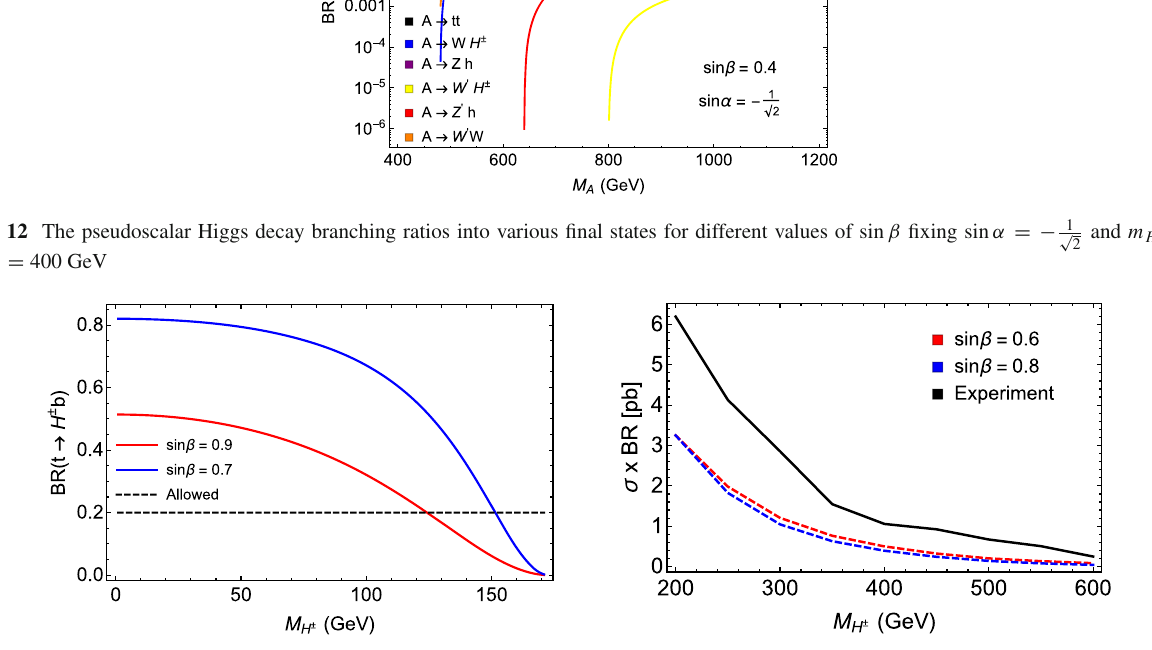
the charged Higgs, albeit only slightly. (Right): The LHC experimental exclusion limit in the channel H ± → t ¯ b – we have translated the limits to the present model for two different values of sin